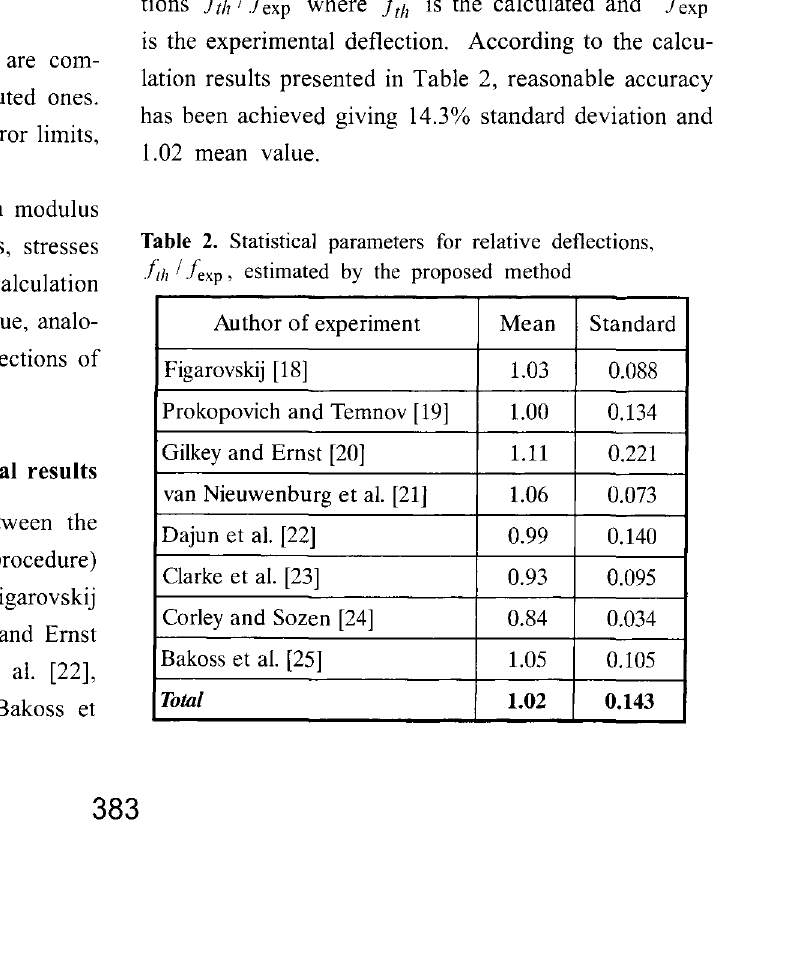
Table 2. Statistical parameters for relative